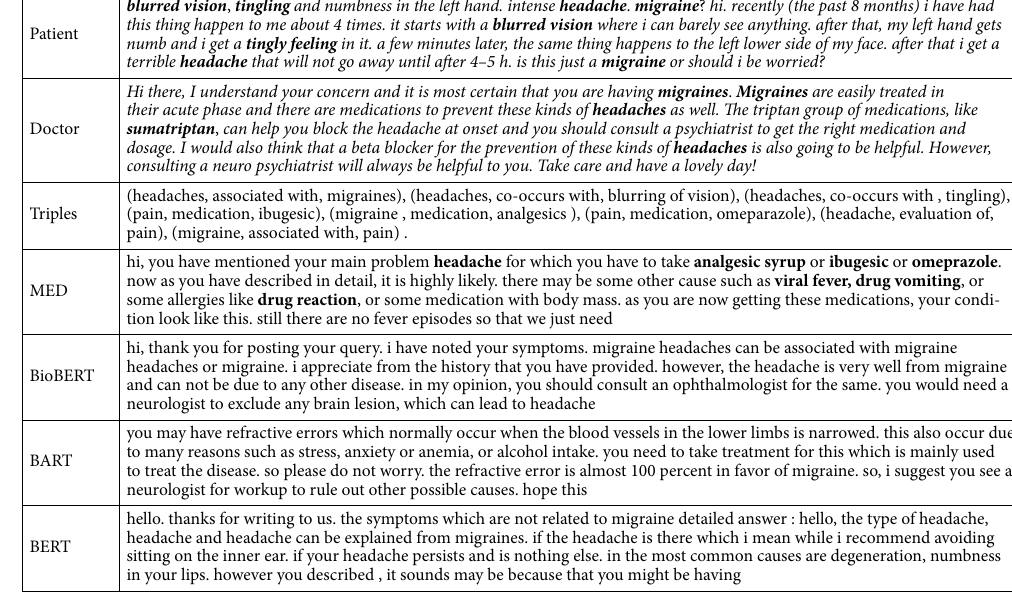
Table 10. Case study on a sample from the Covid dataset. Triples show the corresponding medical knowledge for each patient-doctor utterances.